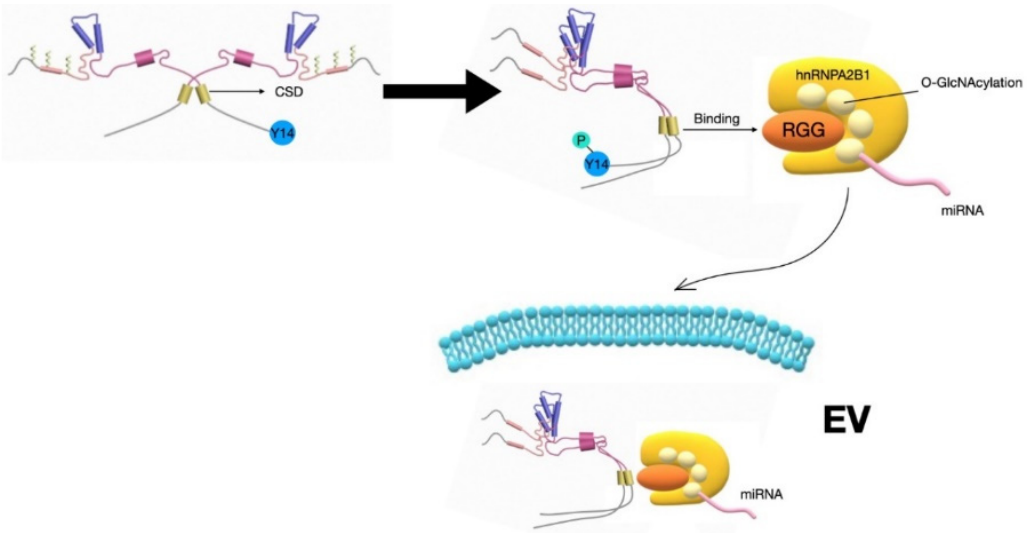
Figure 3. Schematic diagram of cav-1-mediated selection of EV miRNAs via hnRNPA2B1. In the presence of noxious stimuli, such as oxidative stress, cav-1 Y14 is phosphorylated and results in conformational change of cav-1. This pY14-induced change exposes the CSD to bind with the hnRNPA2B1 RGG domain. The interaction of cav-1 and hnRNPA2B1 leads to the encapsulation of both hnRNPA2B1 and its bound miRNAs into the EVs along with cav-1.